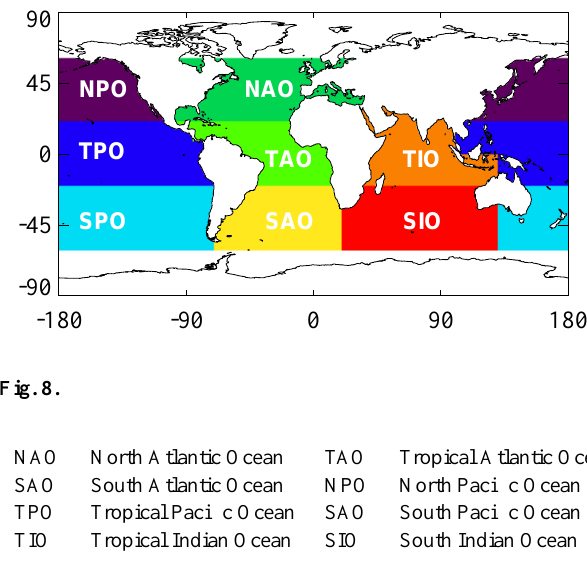
Table 4. Trends in 550nm AOD, in units of decade − 1 , from re- gional time-series. The uncertainties are the 1 σ estimates propa- gated from the standard deviation of each point in the time-series.